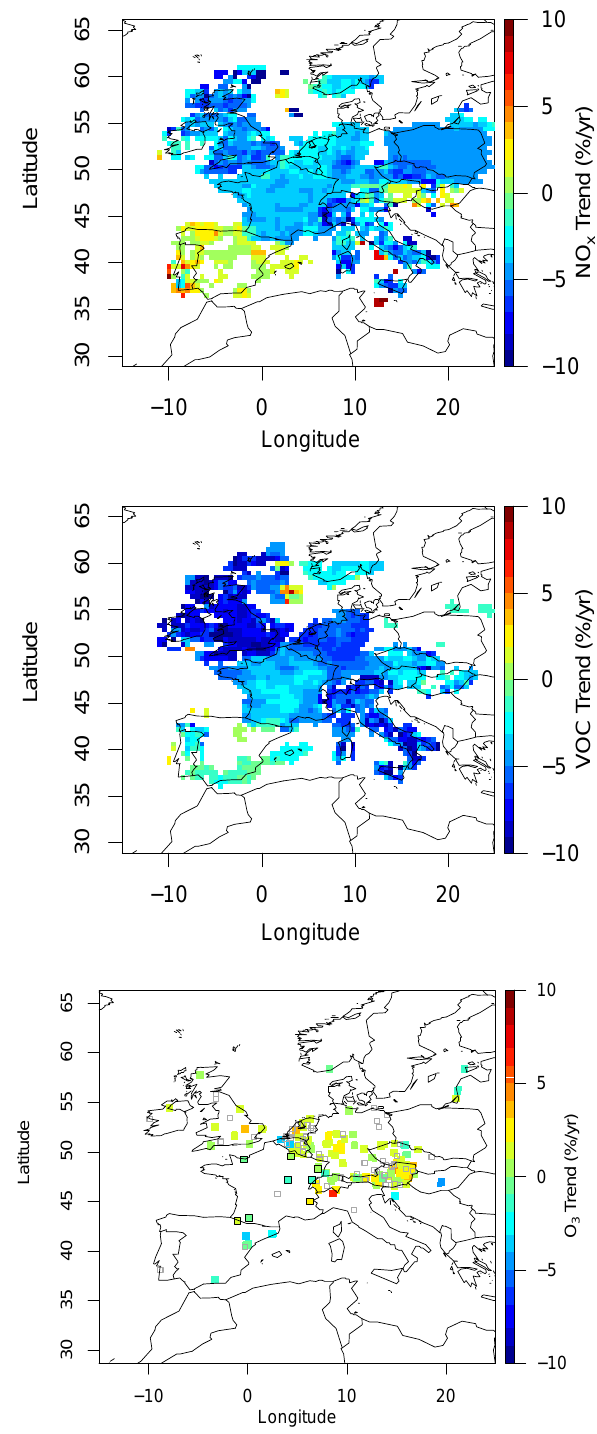
Fig. 9. Spatial distribution of significant (p < 0.1) annual trends (between -10 to 10 %/yr) in NO x (top), VOCs (middle) (both from the EMEP emission inventory, see text for details) and mean O 3 (bottom) 1996-2005 inclusive. Open squares = sites with no sta- tistically significant trends, black lined squares are O 3 surface data 1995-2003 inclusive from Sicard et al. (2009)